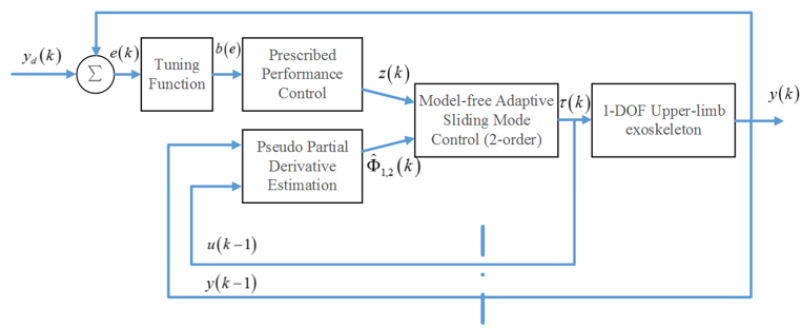
Figure 4. MFAC-SMC-PPC control framework with a tuning